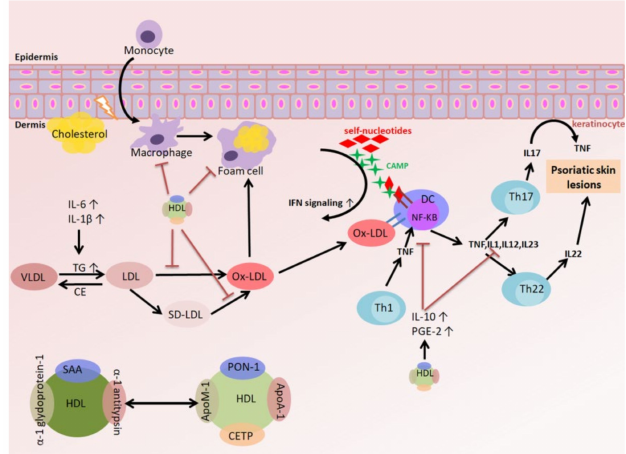
Figure 1. Immune cells and lipoprotein-associated cytokines implicated in psoriasis pathogenesis. Characteristic markers and cytokines related to the interleukin (IL)-17 / IL-23 immune signature of T cells, lipoprotein, dendritic cells (DCs), and associated immune cells in psoriatic skin